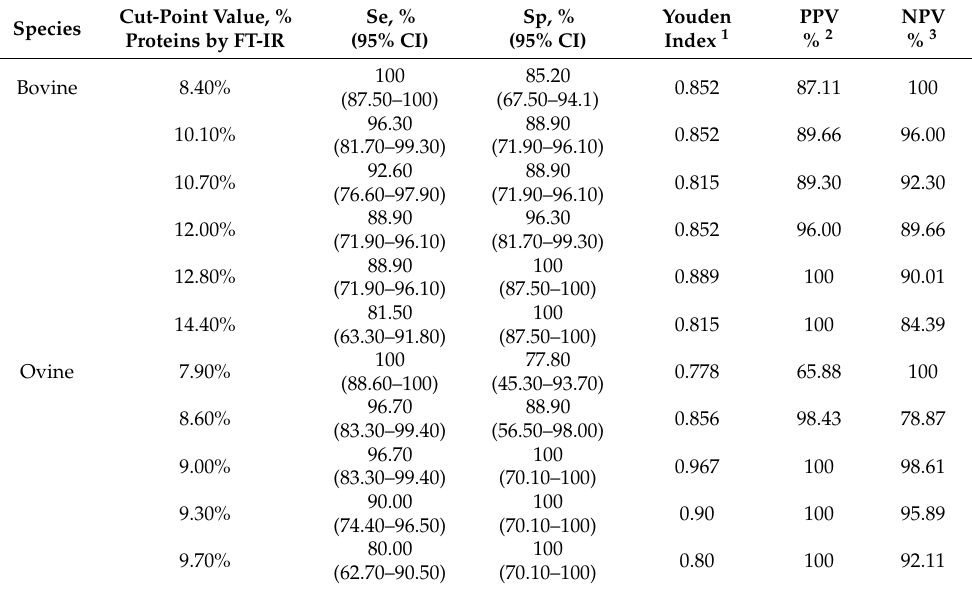
Table 2. Sensitivity (Se), specificity (Sp), Youden index, positive predictive value (PPV), and negative predictive value (NPV) for different MilkoScan FT-plus cut-off values compared with values of 50 g/L of IgG in bovine colostrum (n = 54) and 20 g/L of IgG in ovine colostrum (n = 39), measured by RID assay (gold standard